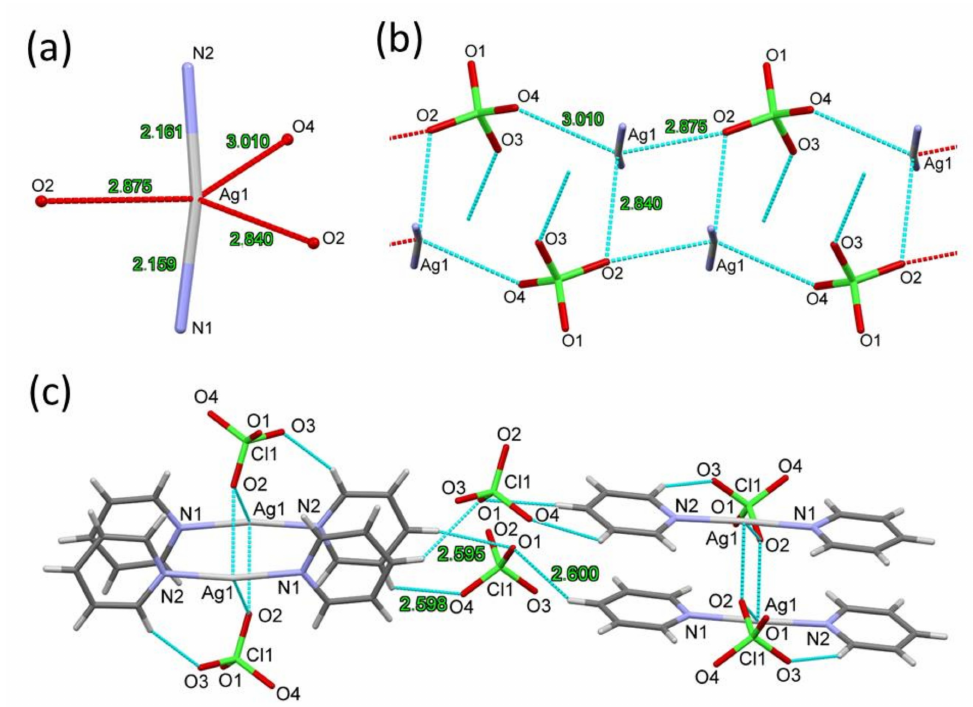
Figure 4. The coordination sphere of the Ag + cation in compound 1 ( a ) and the 1D coordination network of compound 1 ( b ) with the chain of dimers in the ac diagonal formed by O1 and O4 ( c ). The neighboring dimers were found to be connected by the weak C13-H13 ··· O1, C23- H23 ··· O1 and C24-H24 ··· O4 intermolecular interactions (a), and the almost perpendicular alternating positions of the dimers of compound 1 were shown to be built up along the ac diagonal (b) (Figure 4c). π ··· π interactions were shown to contribute to the